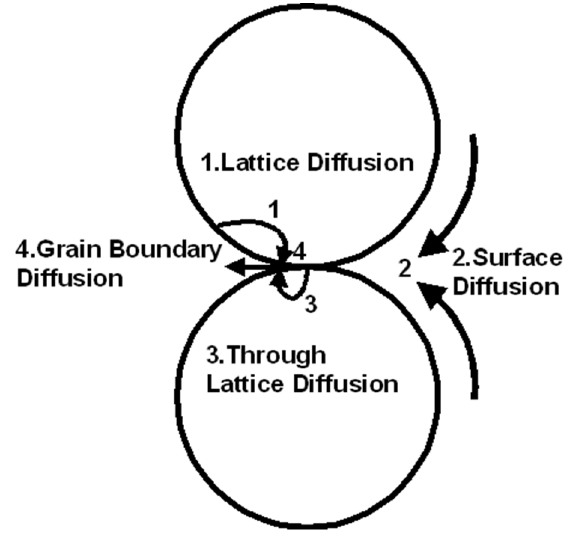
Figure 5. A schematic is representing various atomic diffusion paths between two contacting particles. Reprinted with permission from Ref. [31].